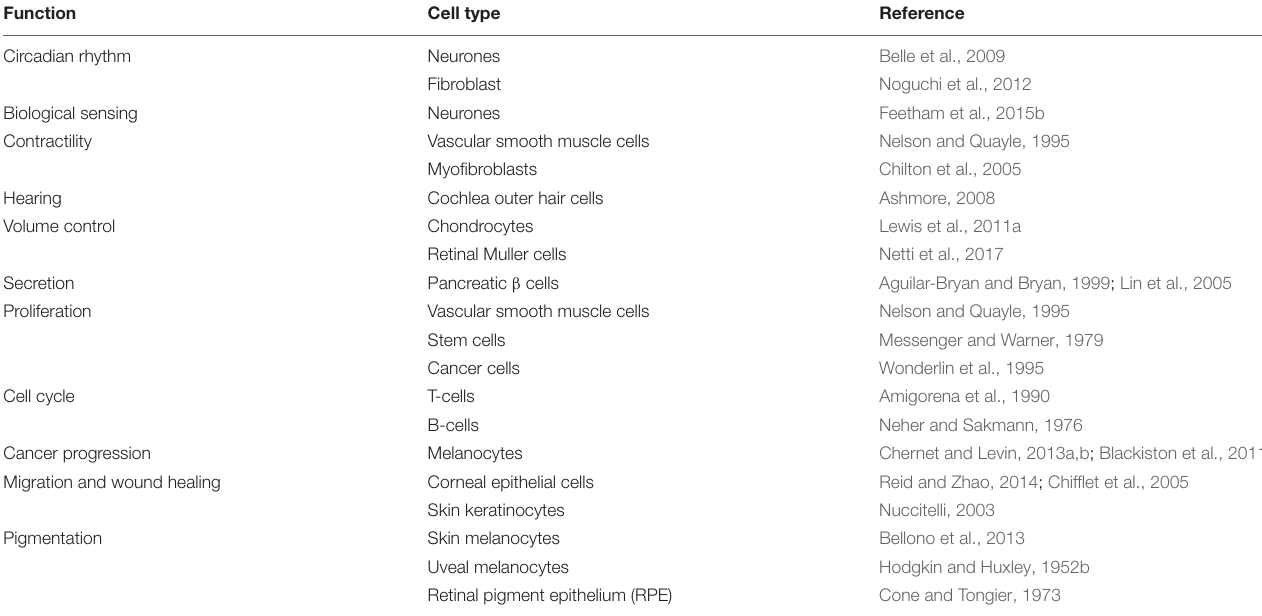
TABLE 1 | Different functions and the cell types associated with these functions that are regulated by the RMP are shown.